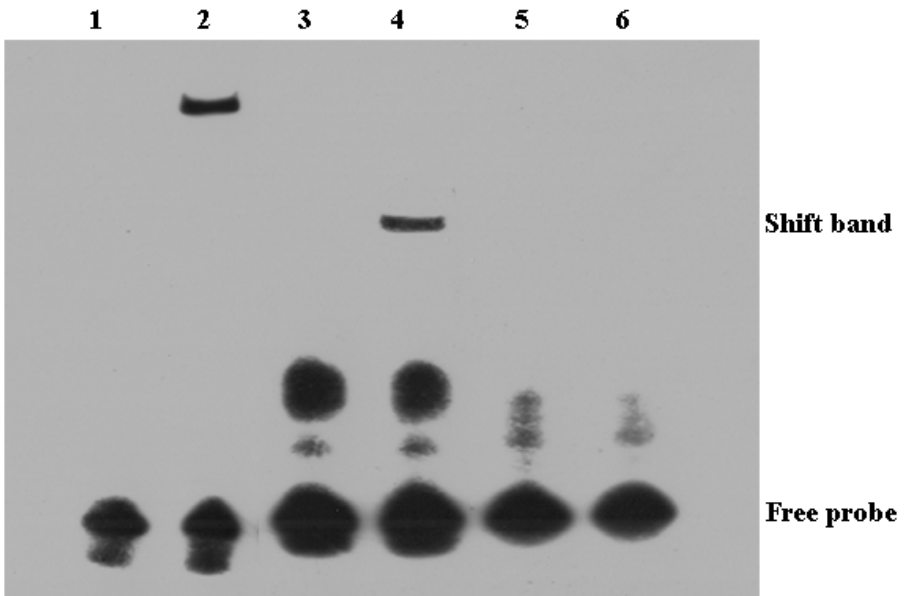
Figure 10. Binding reactions of IRF1 and ToIFNa3 promoter. Biotin-labeled EMSA probes were incubated with lysates of HEK293T cells containing ToIRF1 protein. WT, wild-type probe; MT: